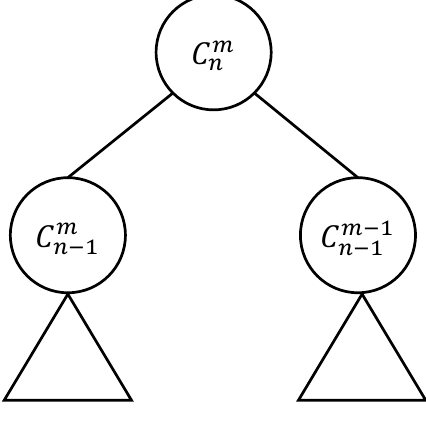
Figure 6. An AND/OR tree for C m n